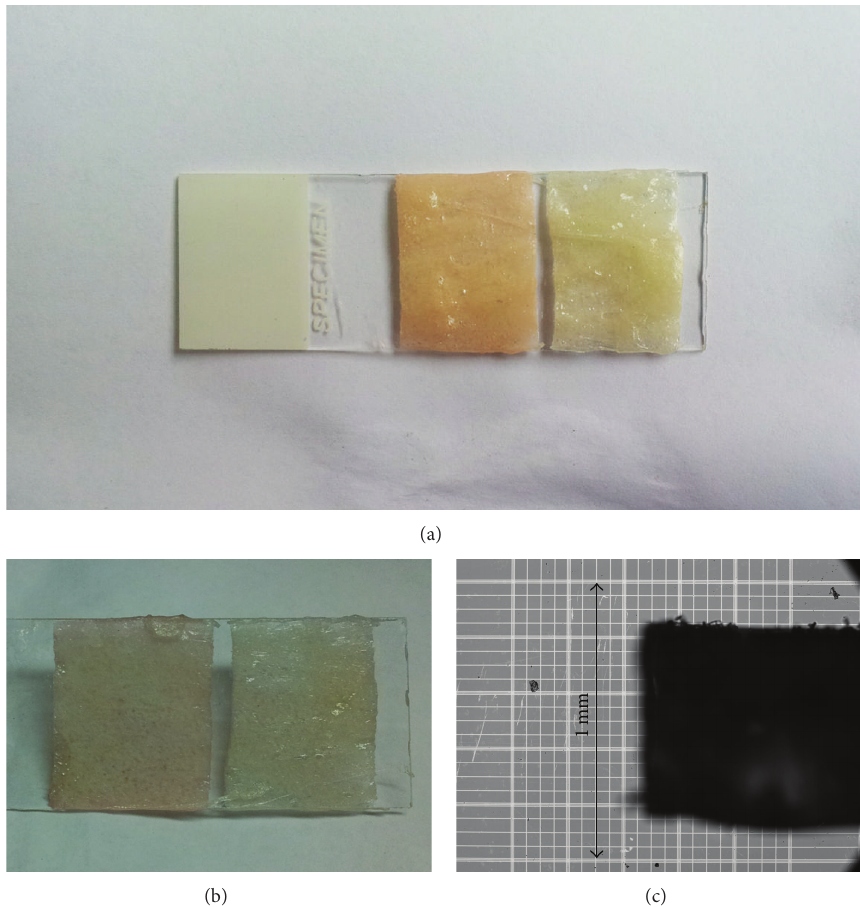
Figure 1: A single gelatin film was prepared using the described methodology and was placed on a glass slide, mechanically separated, and irradiated at 27 J/cm 2 . (a) UV-irradiated sample. (b) Control sample without irradiation (masked in aluminum foil). (c) Thickness of gel as seen by light